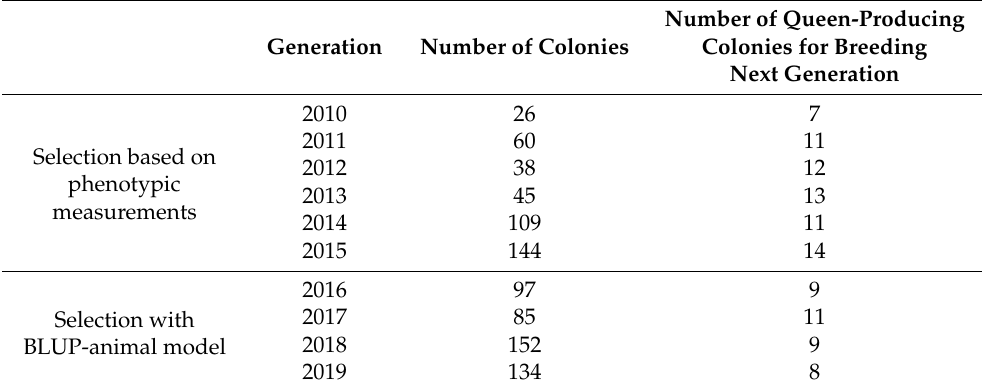
Table 1. Number of colonies and number of queen-producing colonies in each generation in the UL-CRSAD breeding program. Phenotypic measurements were taken each year in all